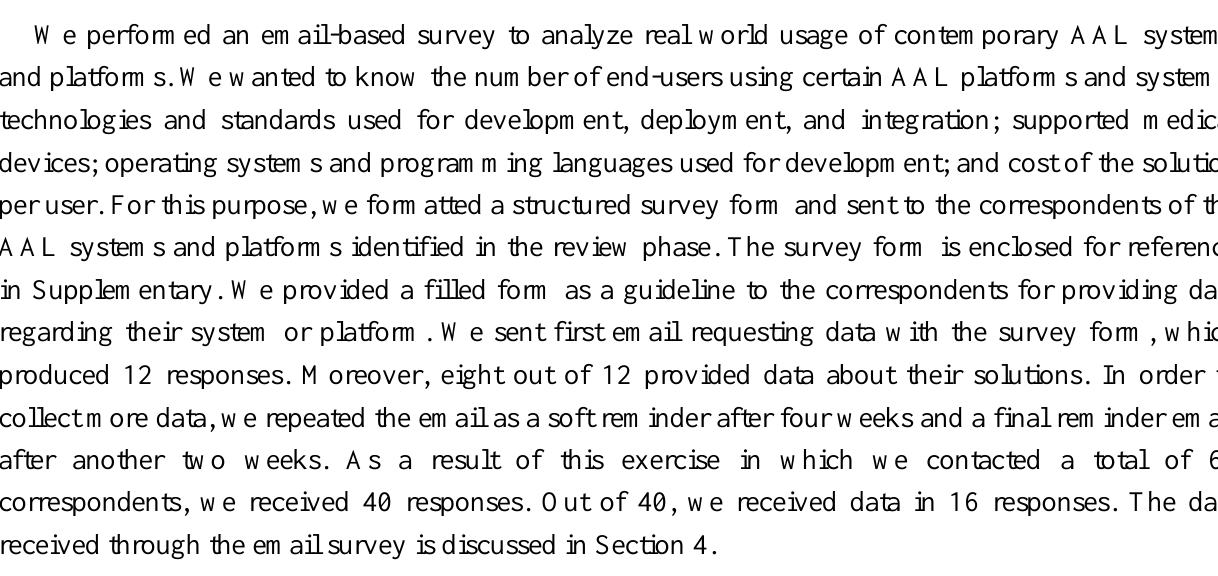
Figure 1: Review process